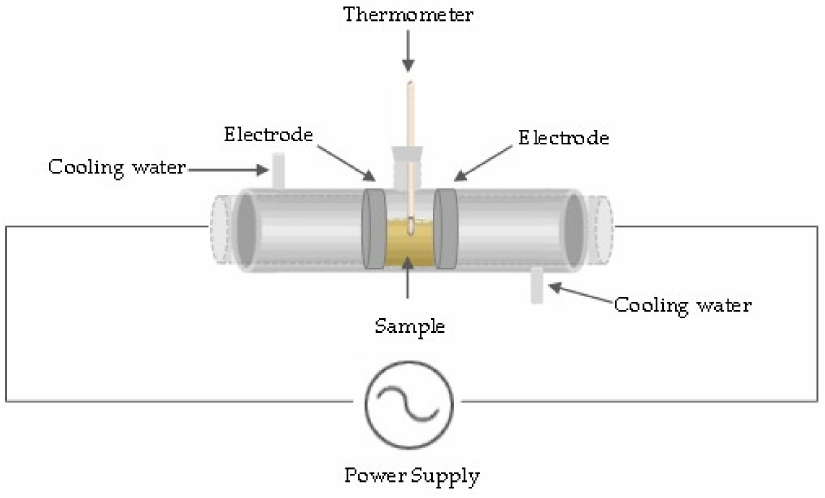
Figure 6. Schematic representation of an OH